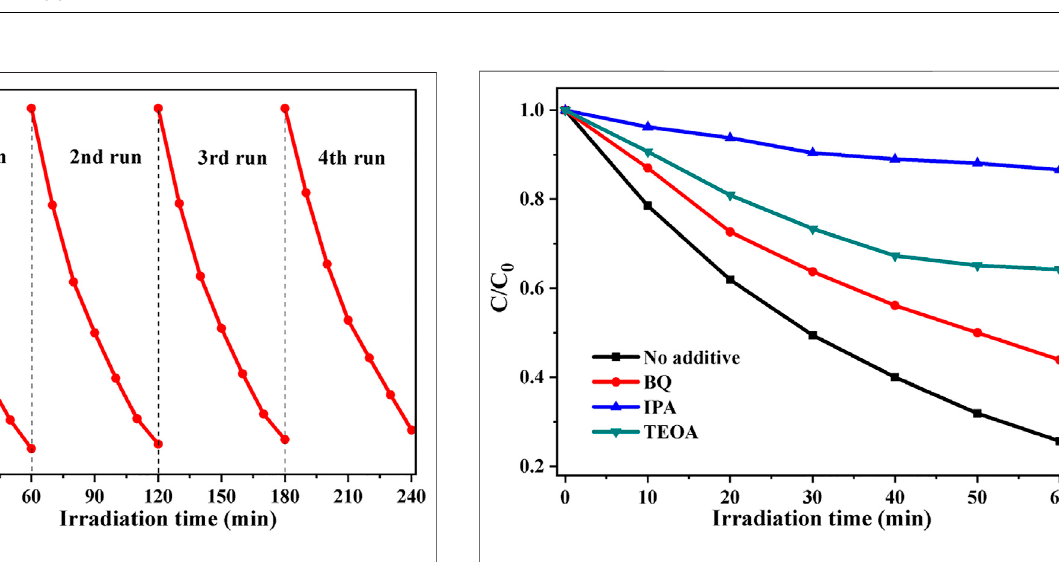
FIGURE 7 | Photocatalytic MB degradation by CdS/MCC-10% with the addition of different